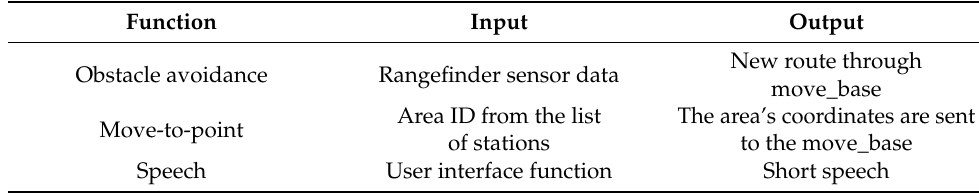
Table 2. A summary of the developed navigation functions. Function